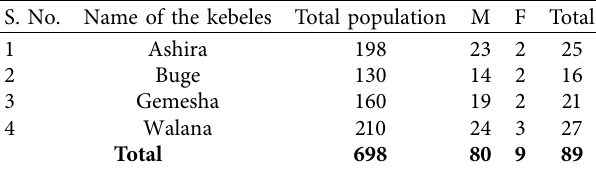
Table 1: Total number of respondents and name of